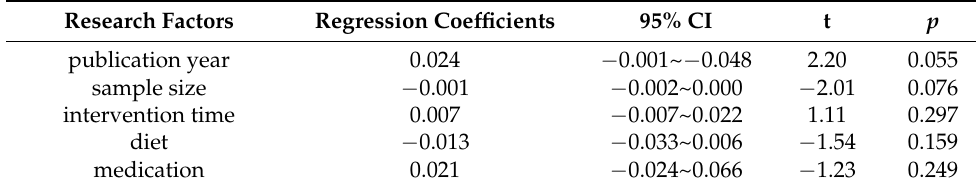
Table 5. Meta regression analysis of heterogeneous factors of HDL.